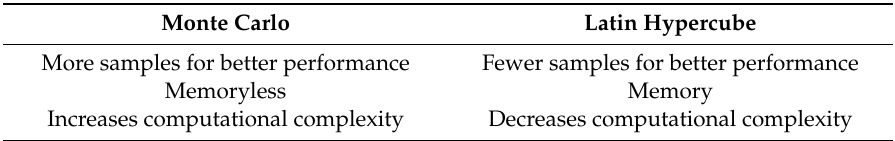
Table 1. Monte Carlo and Latin hypercube comparison.